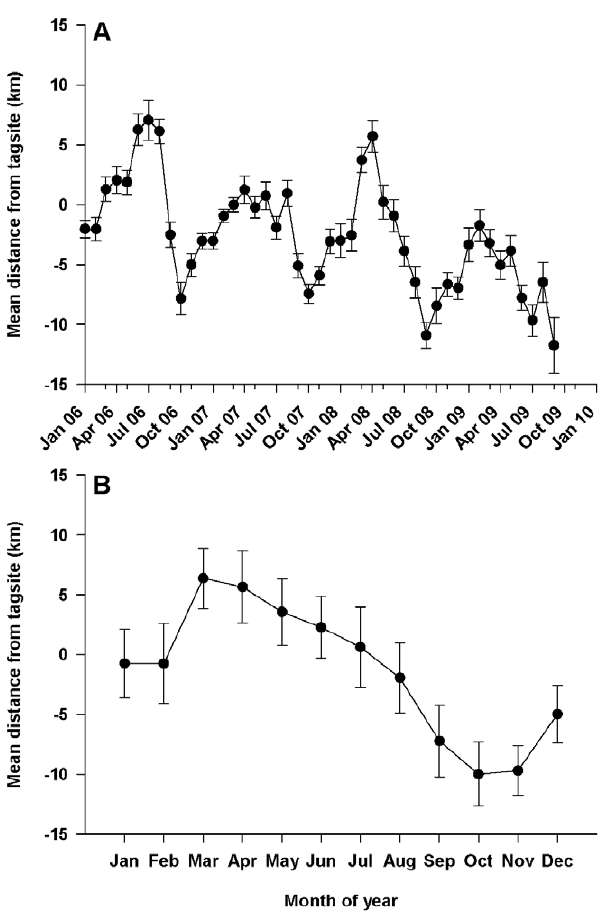
Figure 5. Mean distance from tagging location (km) of sixgill sharks in Puget Sound, WA, USA. Values were calculated across all sharks for A) each month from 2006 to 2009, and for B) each month across all